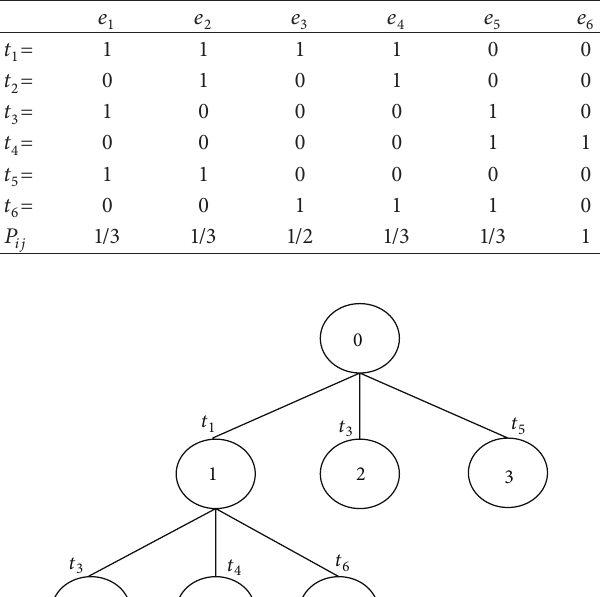
Table 2: Example of sampling pattern for 6 𝑇 𝑥 s.